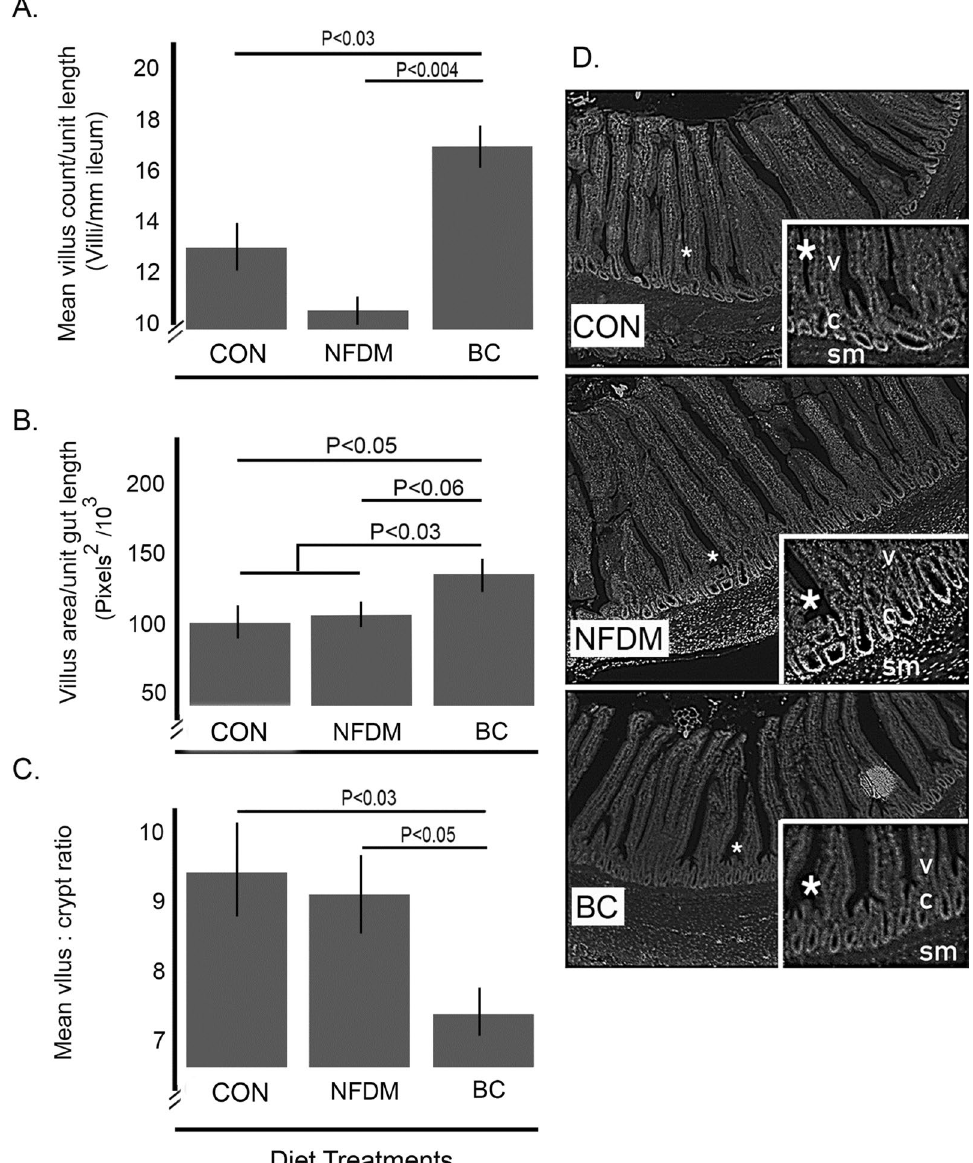
Fig. 2 The BC-supplemented diet increases the villus surface abundance. The effects of inclusion of nonfat dry milk (NFDM) or the bovine colostrum fraction (BC) to the standard feed (Control) on the morphology of the ileum. Data represent the means SEM of the number of villi ± counted per standardized length of tissue (Panel A ) or the calculated area of the villi as associated with the diet treatments fed to the chickens (Panel B ), or the ratio of the villus height to crypt depth (Panel C ). Panel D depicts representative images of the diet-associated ileal architecture. (Control, basal diet, n 6. NFDM. n 6. BC, n 10). For reference, “V” villi, “C” crypts, and “SM” = = = = = =